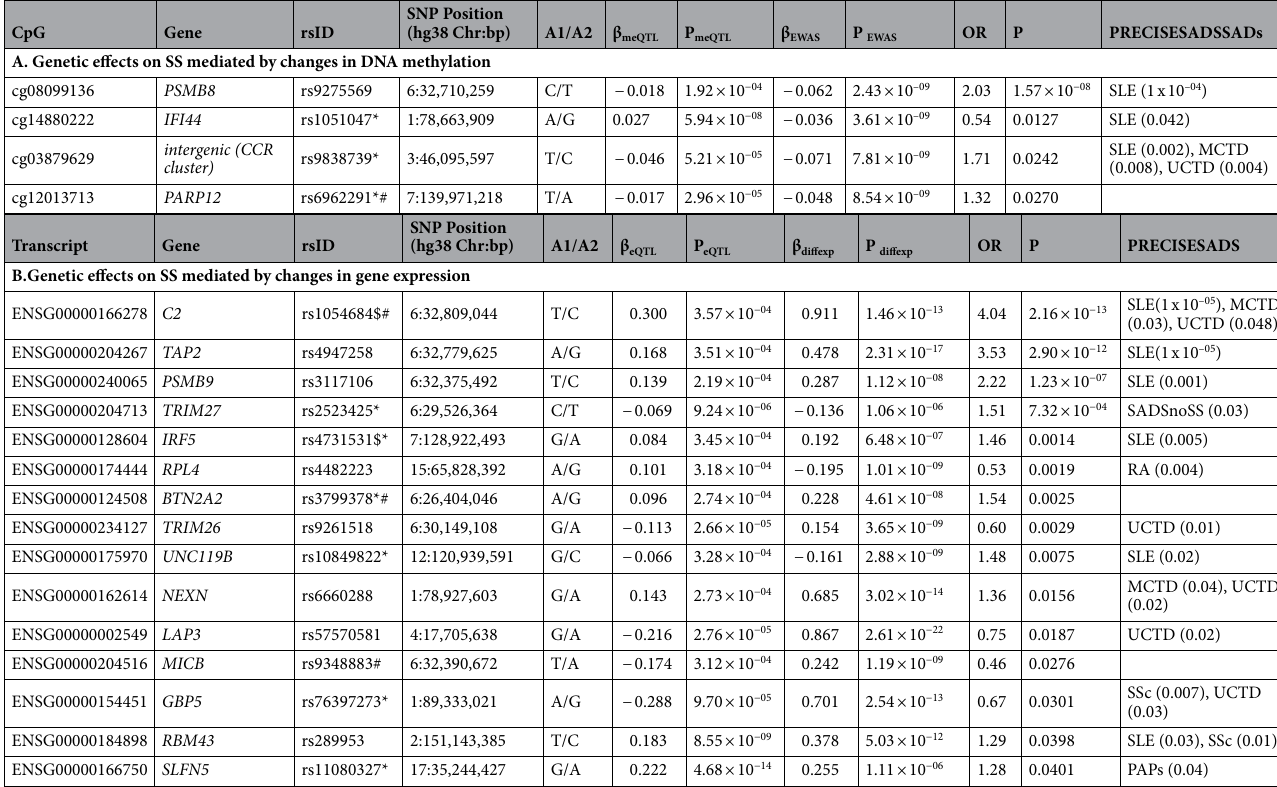
Table 2. Genetic association of SS-meQTLs and SS-eQTLs with SS and other related SADs mediated by DNA methylation or gene expression changes. Alleles represent major allele first, and then the minor allele, which is the allele tested in each analysis. β meQTL represents the DNA methylation change with the increased in dosage of the minor allele. P meQTL corresponds to the P value from the linear regression model that regresses out the number of minor alleles for a given SNP to DNA methylation levels adjusting by age, sex, batch effects, estimated cell proportions, disease status and first genetic component. β EWAS represents the DNA methylation difference between SS and healthy controls from the epigenome-wide association study together obtained by linear regression model in which DNA methylation levels are regressed out by SS status and adjusted by age, sex, batch effects and estimated cell proportions. OR represents the Odd Ratio obtained from genetic association testing based on logistic regression modeling which the SS statuts is regressed out by number of minor alleles for a given SNP adjusted by age, sex, batch effects, estimated cell proportions and first genetic component and its corresponding. P represents the P -value obtained in the genetic associations. SAD (OR, P) represents the odd ratio and P value obtained in genetic testing for other diseases. RA = Rheumatoid Arthritis, SLE = Systemic Lupus Erythemathosus, UCTD = Undifferentiated Connective Tissue Disease, SSc = Systemic Scleroderma, PAPs = Primary anti-phospholipid syndrome. SADSnoSS = All SADs patients excluding SS. Genomic positions are based on the hg19 human reference sequence build (GRCh37). * eQTL reported